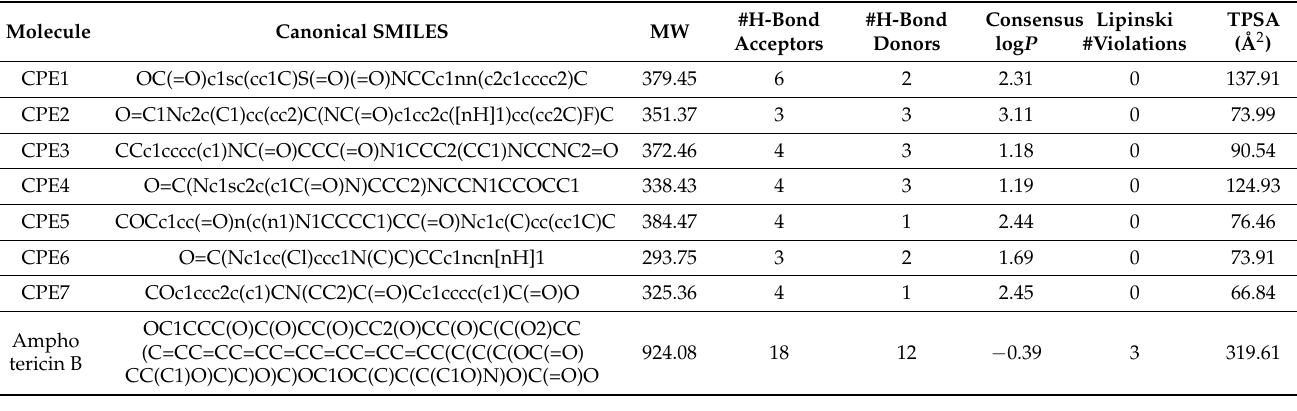
Table 4. Physicochemical properties. MW: Molecular weight (g/mol). #H-bond acceptors: Number of hydrogen bond acceptors. #H-bond donors: Number of hydrogen bond donors. Consensus log P : Average of logarithm of compound partition coefficient between n-octanol and water, as calculated by several methods. Lipinski: Number of Lipinski rule of five violations. TPSA: Topological polar surface area.